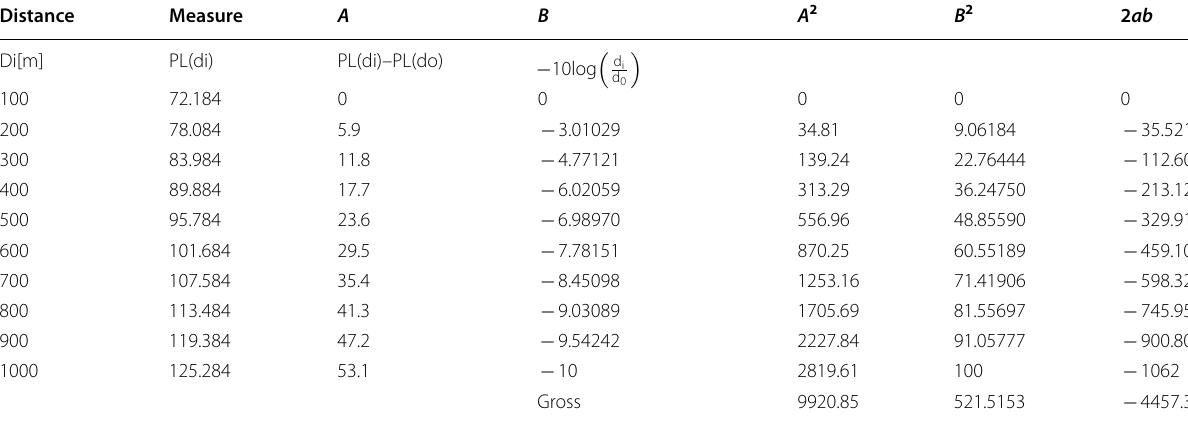
Table 6 Predicted path loss for Faysal